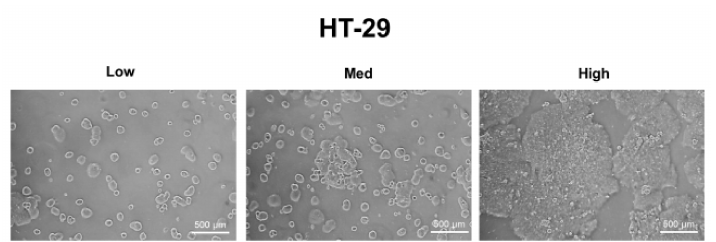
Figure 1. The three cell confluency conditions of A549, MDA-MB-231, and HT-29 cells. A549, MDA-MB-231, and HT-29 cells were grown until they reached the appropriate cell densities. Low cell density was defined as approximately 20~30% cell confluency, medium density as approximately 40~60% cell confluency, and high density as approximately 80~90% cell confluency. Representative images of each cell condition are shown in the